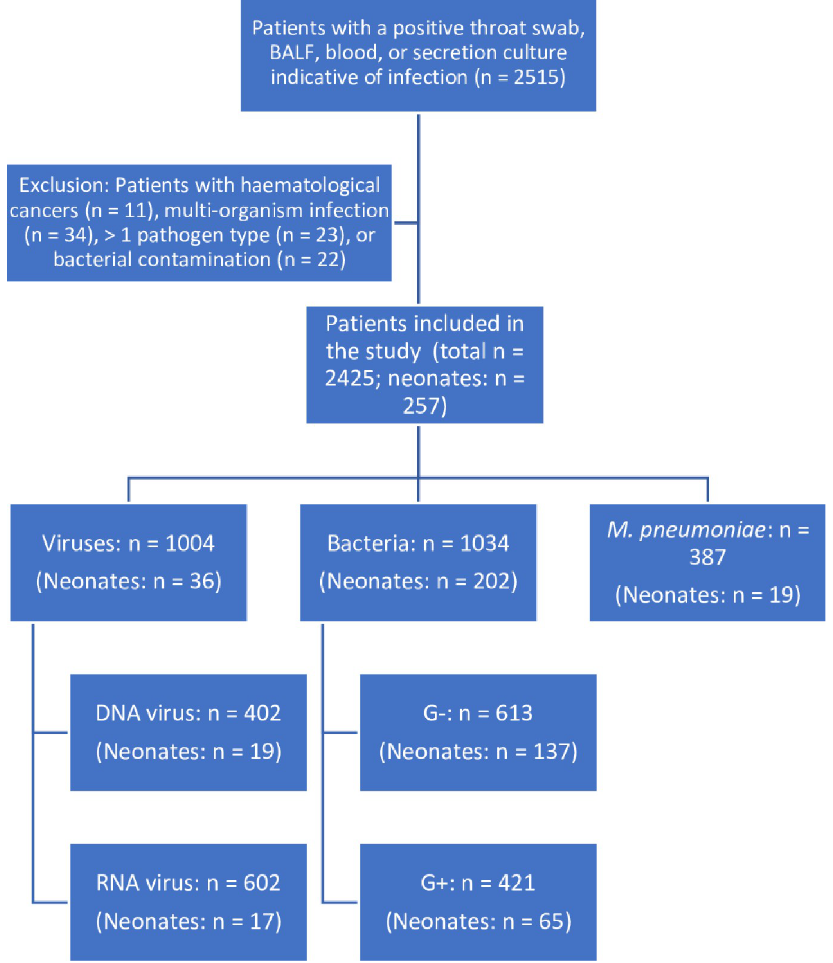
Fig 1. Flowchart for patient selection. The numbers of neonates are presented in parentheses. BALF, bronchoalveolar lavage fluid; M . pneumoniae , Mycoplasma pneumoniae ; G+, Gram-positive organisms; G − , Gram-negative